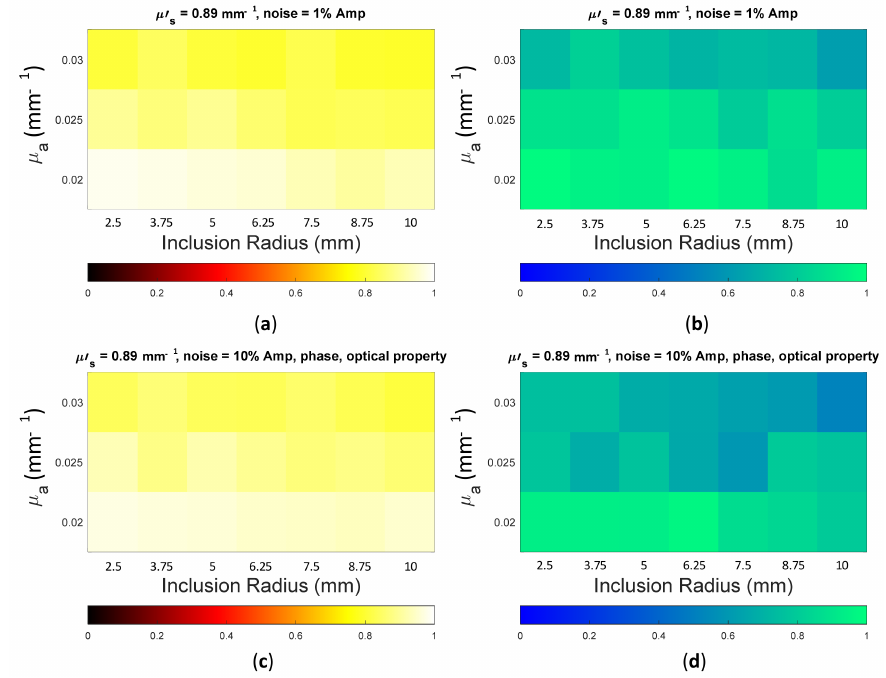
Figure 22. Color map of the MS-ISSIM-S score for ( a ) Figure 19a; ( b ) Figure 19c; ( c ) Figure 20a; and ( d ) Figure